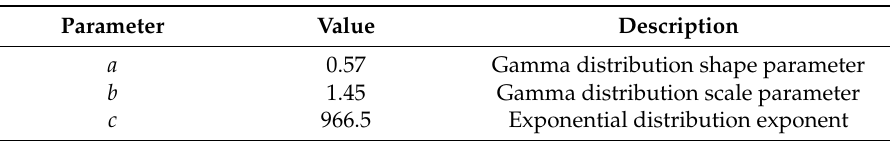
Table 3. Parameters of the fitted distributions. a for the exponential distribution and b , c for the gamma